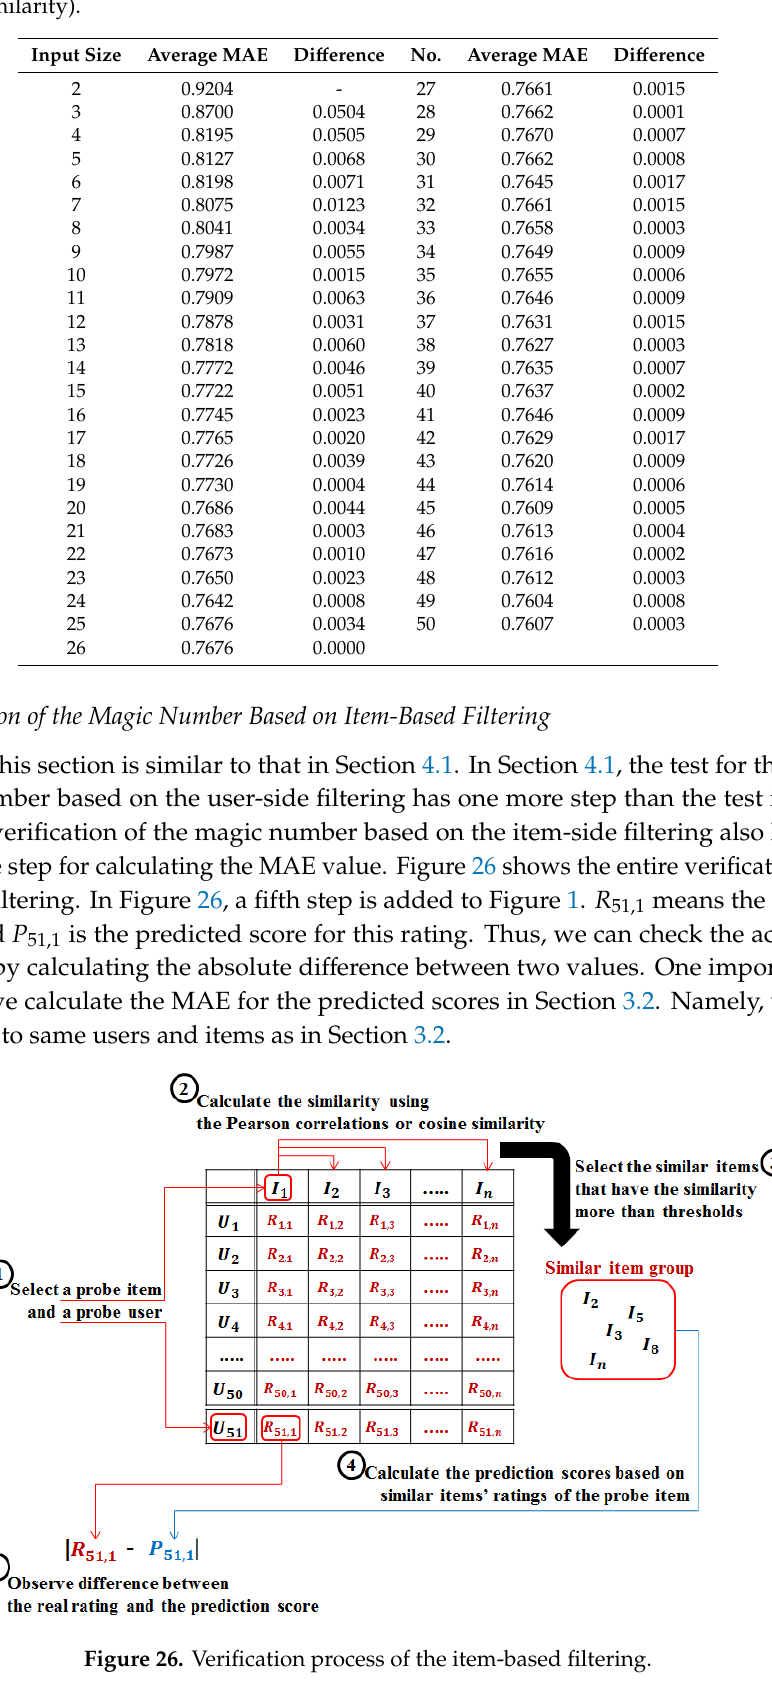
Figure 26. Verification process of the item-based filtering .